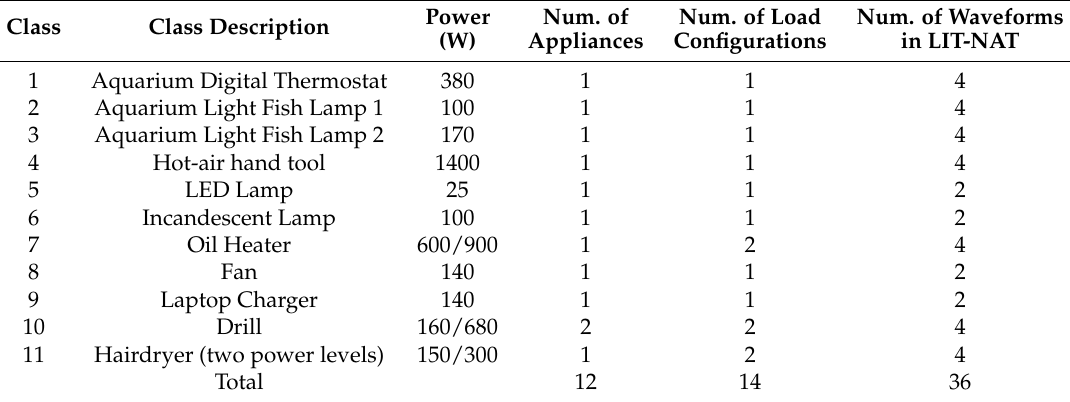
Table 10. Characteristics of the natural subset of the LIT-dataset.